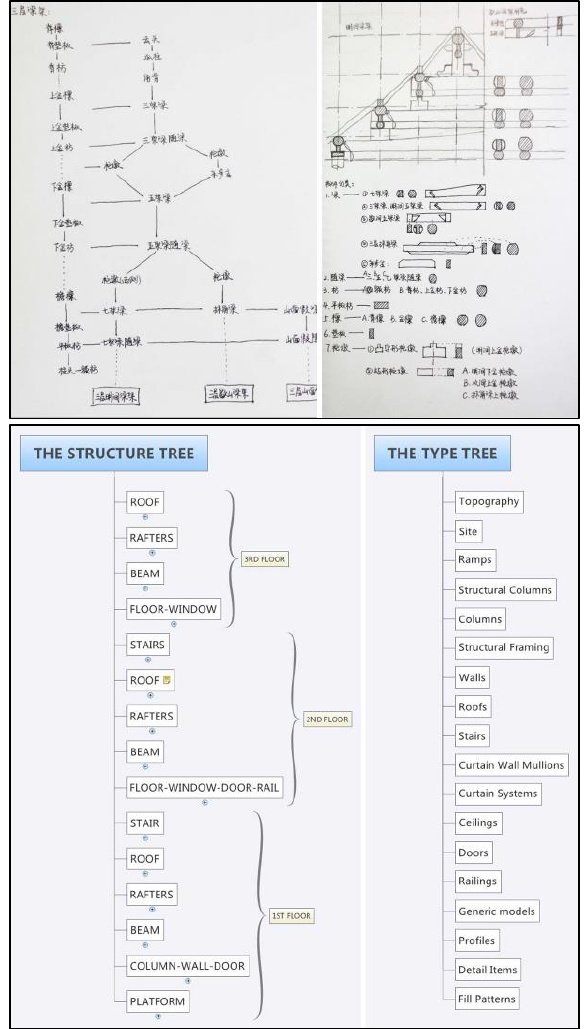
Figure.4 the structure and type tree and sketches of field